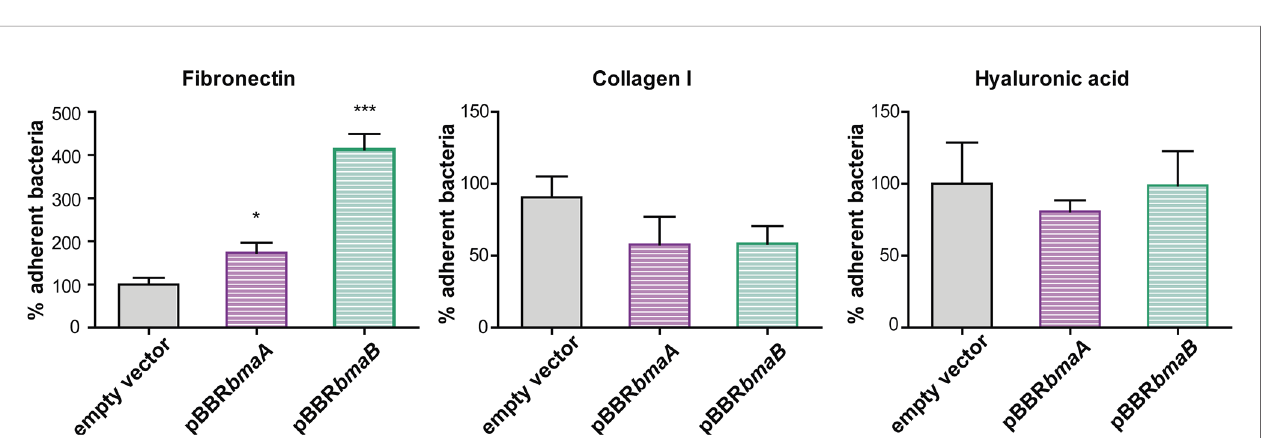
FIGURE 4 | Evaluation of the role of BmaA and BmaB in the adherence to ECM components by heterologous expression. Binding to immobilized ligands of E. coli CC118 with an empty pBBR1-MCS1 (EV), E. coli CC118 pBBR bmaA , and E. coli CC118 pBBR bmaB was assayed. Values correspond to the percentage of binding to ECM components. A value of 100% was assigned to control strain. Data represent the means and standard deviations (SD) of the results of a representative experiment done in triplicate. Three independent experiments were performed with similar results. Data were analyzed by one-way ANOVA followed by a Tukey´s post hoc test. *, signi fi cantly different from control p < 0.05, ***p < 0.0001.